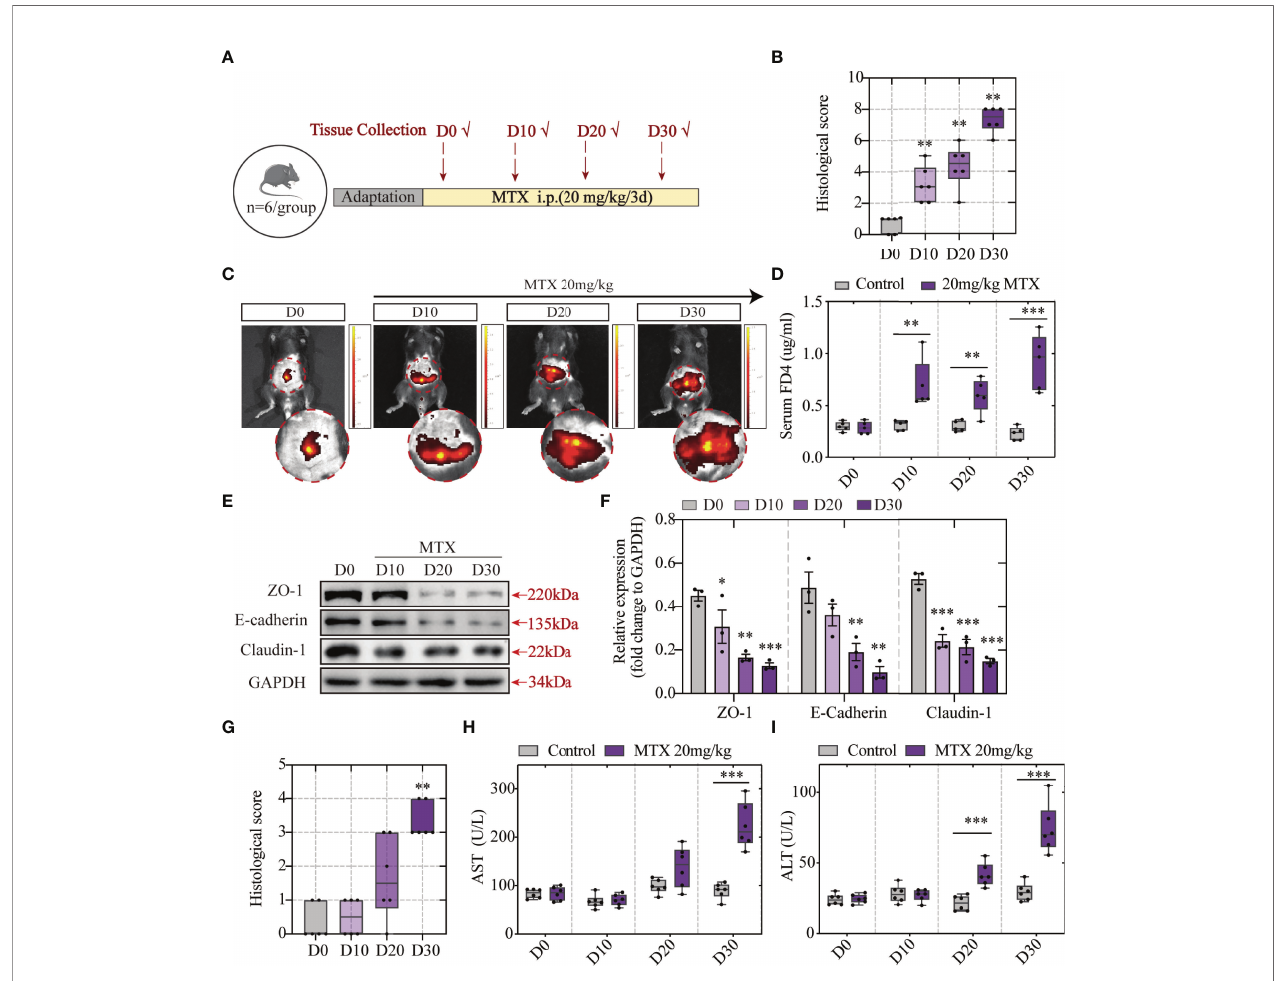
FIGURE 4 | MTX-induced intestinal barrier disruption was detected in advance of hepatic lesion (A) Experiment design. (B) Histological score of colon tissue (n = 6, Kruskal-Wallis test). (C) Representative in vivo imaging of FITC-Dextran leakage. (D) Quanti fi cation of intestinal leakage measured by FITC-Dextran concentration in serum (n = 5, One-way ANOVA). (E) Immunoblot analysis of ZO-1, E-cadherin and Claudin-1 in colon sections from different groups (n = 3, One-way ANOVA). (F) Quanti fi cation of Figure 3E. (G) Histological score of liver tissue (n = 6, Kruskal-Wallis test). (H, I) ALT and AST levels in serum (n = 6, One-way ANOVA). *p < 0.05, **p < 0.01, ***p < 0.001, compared with D0 or